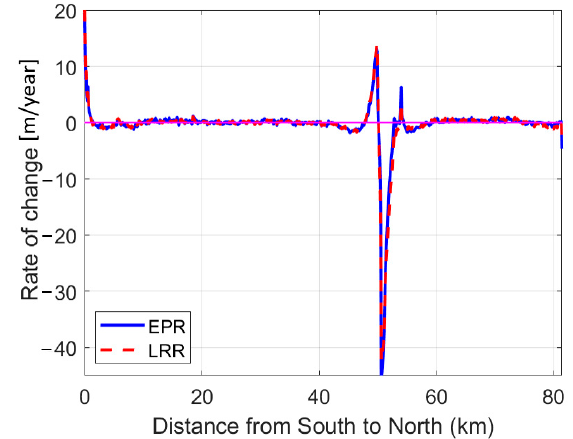
Figure 11. Quantified coastline change rates by EPR and LRR for Quang Nam coast. J. Mar. Sci. Eng. 2021 , 9 , 1124